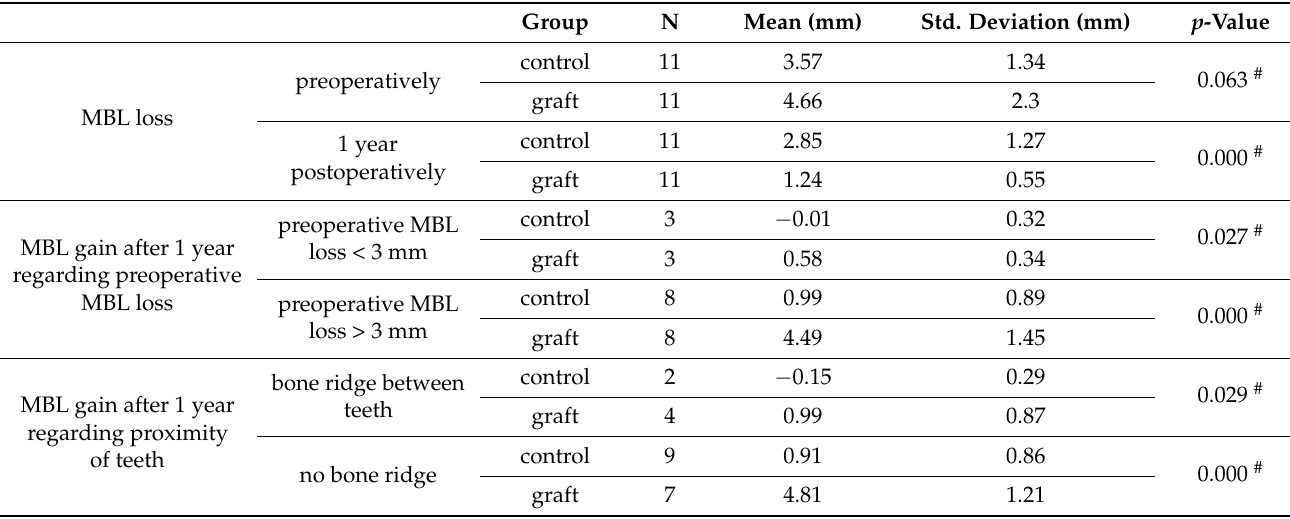
Table 4. Changes of the marginal bone level (MBL) at the distal site of second molar. For statistical analysis One-way ANOVA test ( # ) was